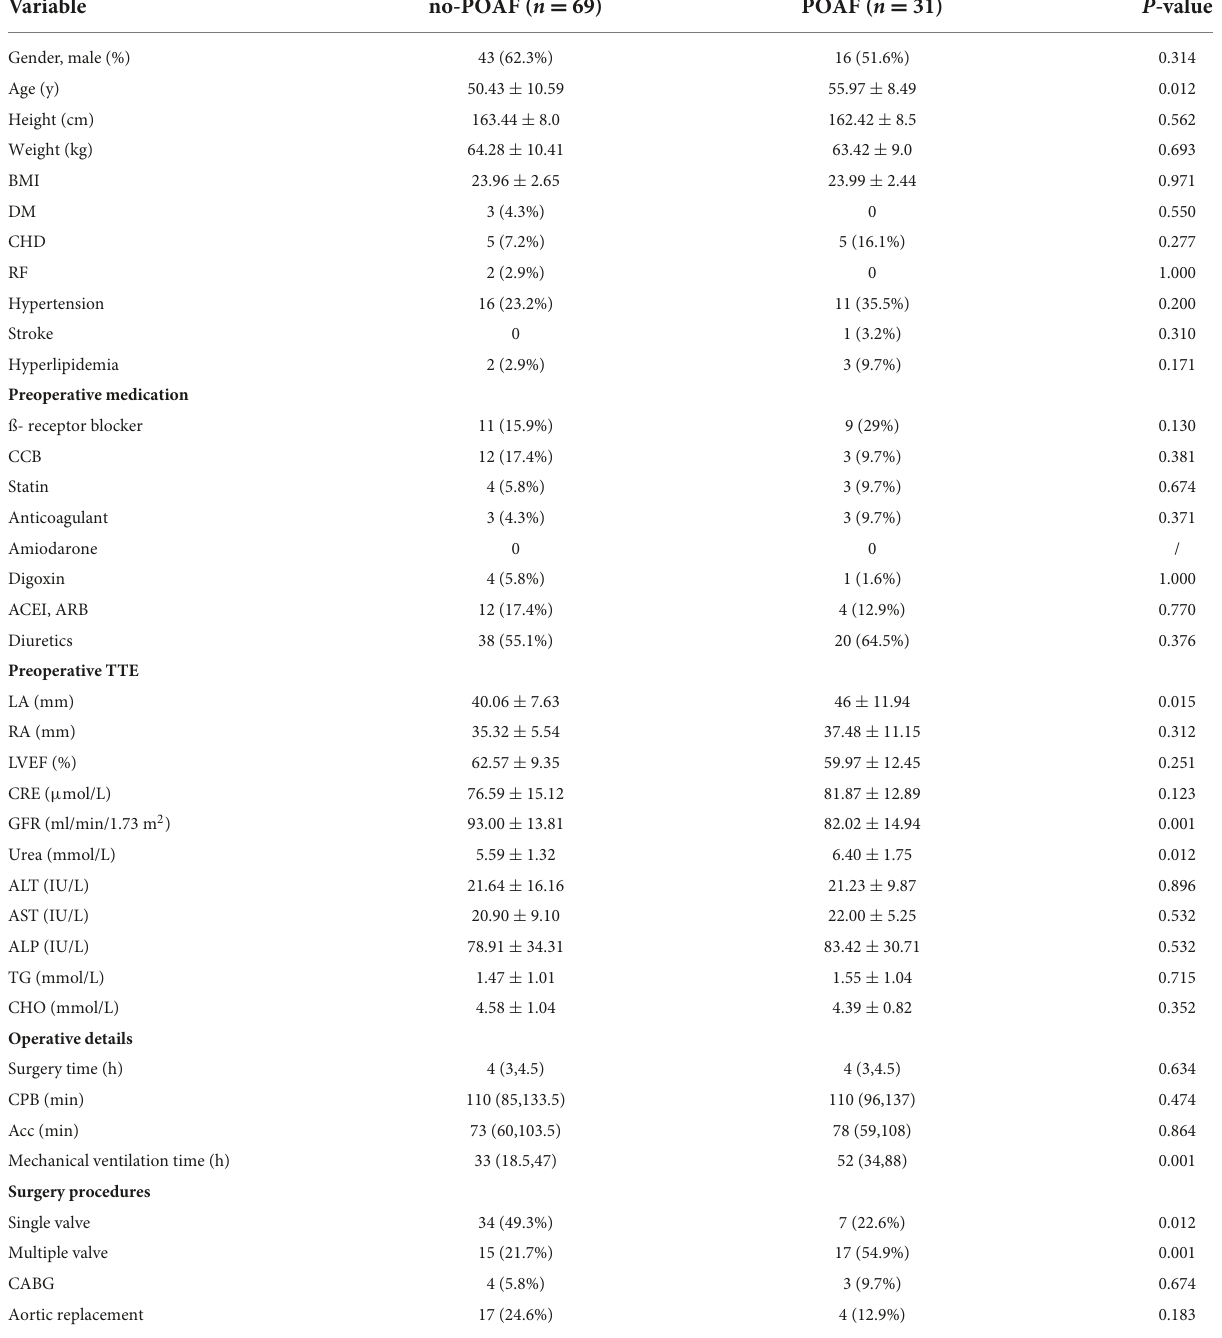
TABLE 1 Patient demographic, clinicopathologic, and operative characteristics.